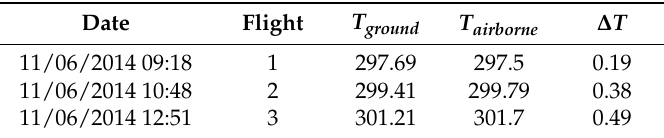
Table 2. Ground ( T ground ) and airborne ( T airborne ) temperatures of a water filled pool and their differences ( ∆ T ) per TIR airborne